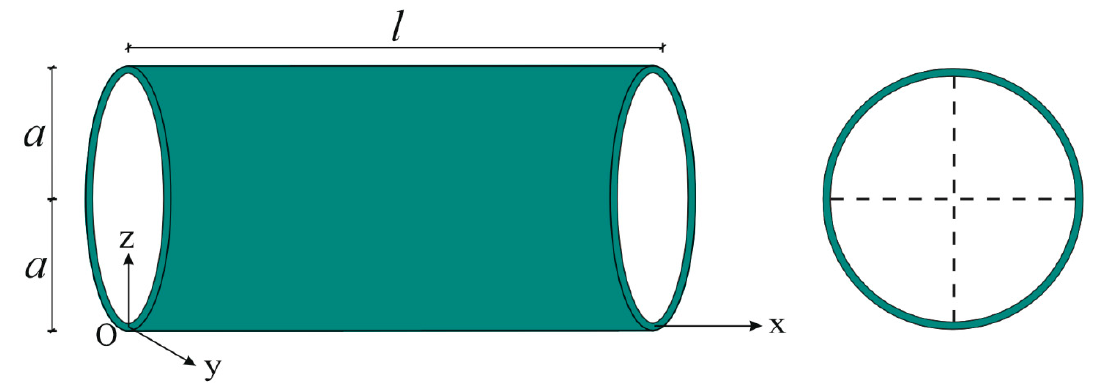
Figure 1. CNT-reinforced composite cylindrical shell and coordinate system.